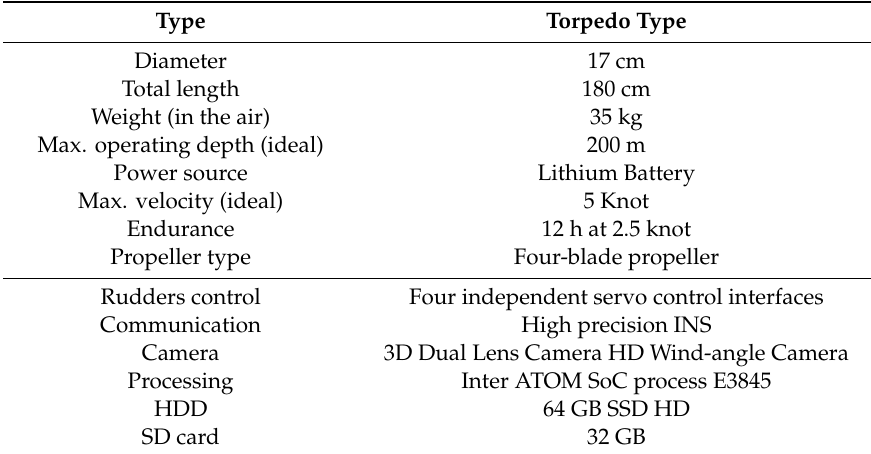
Table 1. Specification of Bigeye